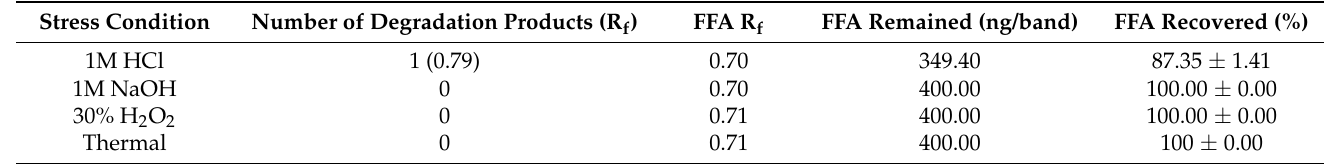
Table 6. Results of forced-degradation studies of FFA under various stress conditions for the greener HPTLC assay (mean ± SD; n = 3).